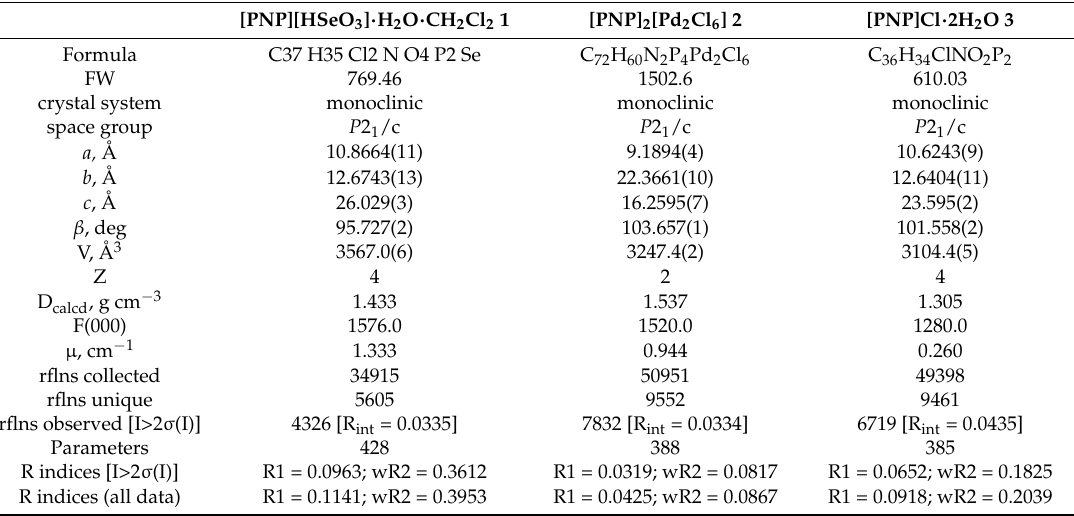
Table 1. Summary of crystallographic data for 1 , 2 and 3